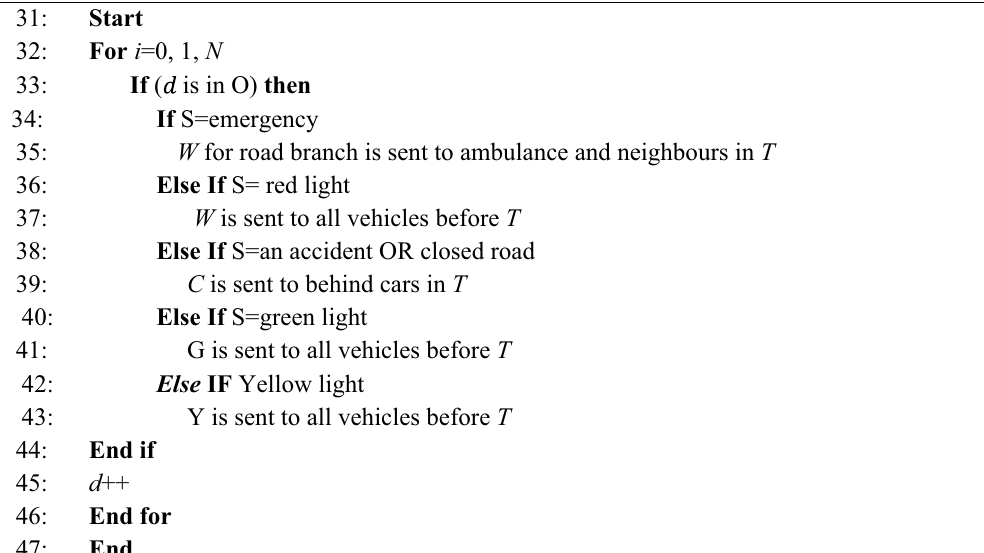
Algorithm 2: Intelligent traffic light warning messages